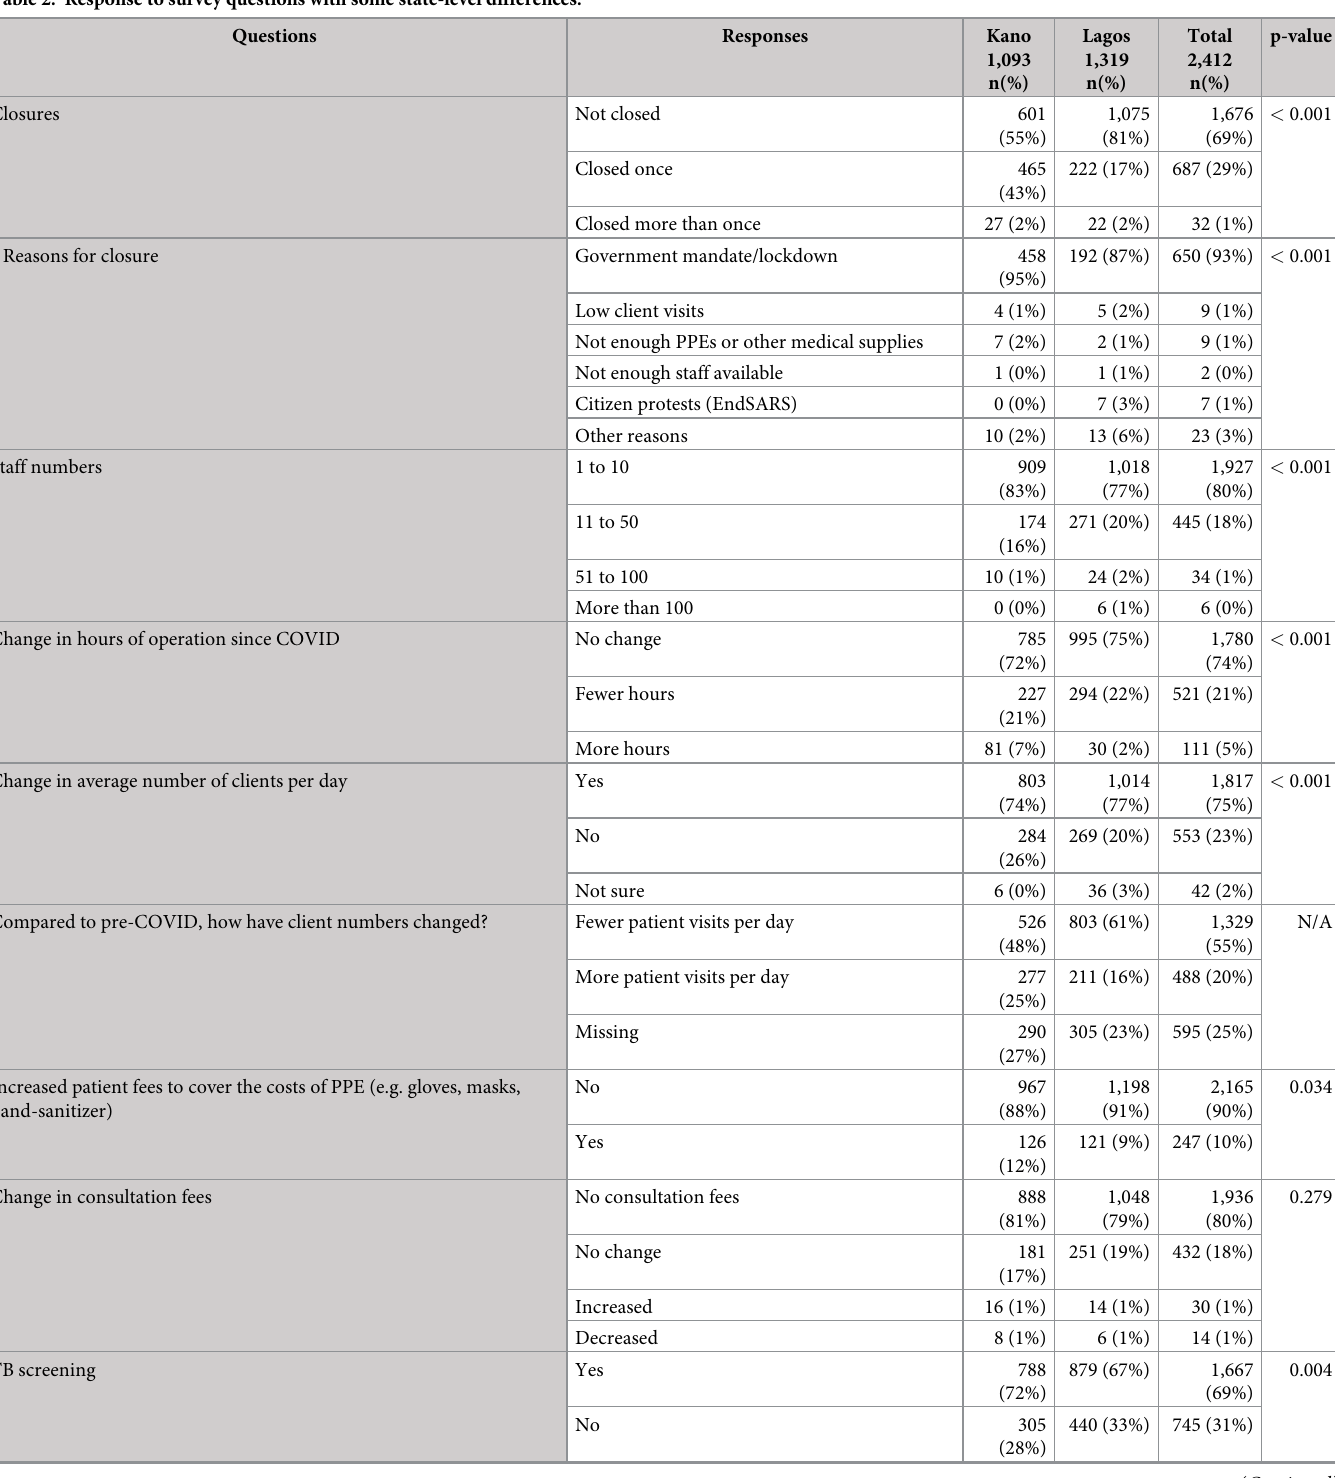
Table 2. Response to survey questions with some state-level